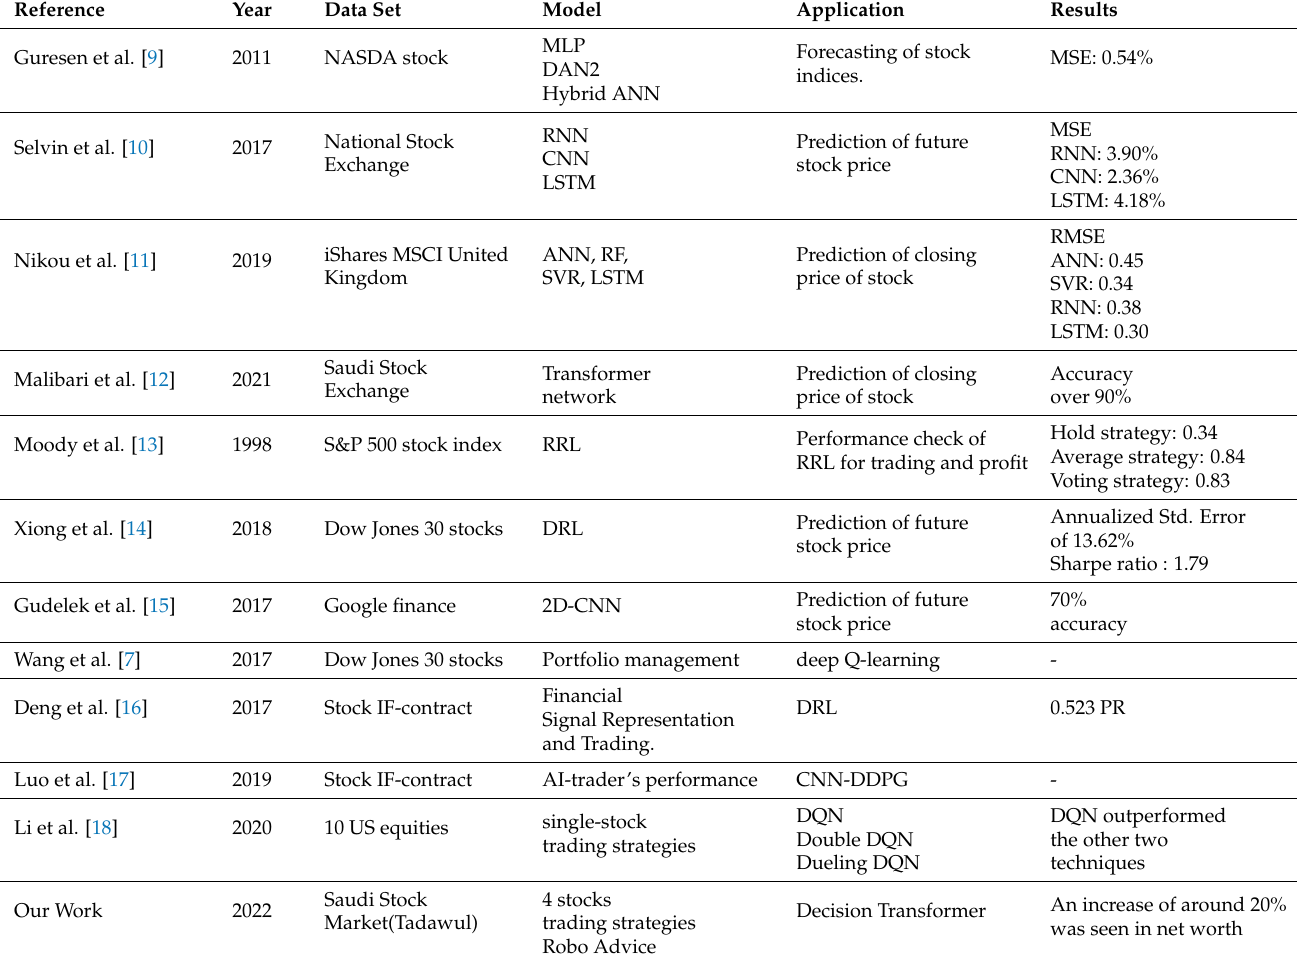
Table 1. Studies focused on the prediction of stocks using ML, DL, and DRL